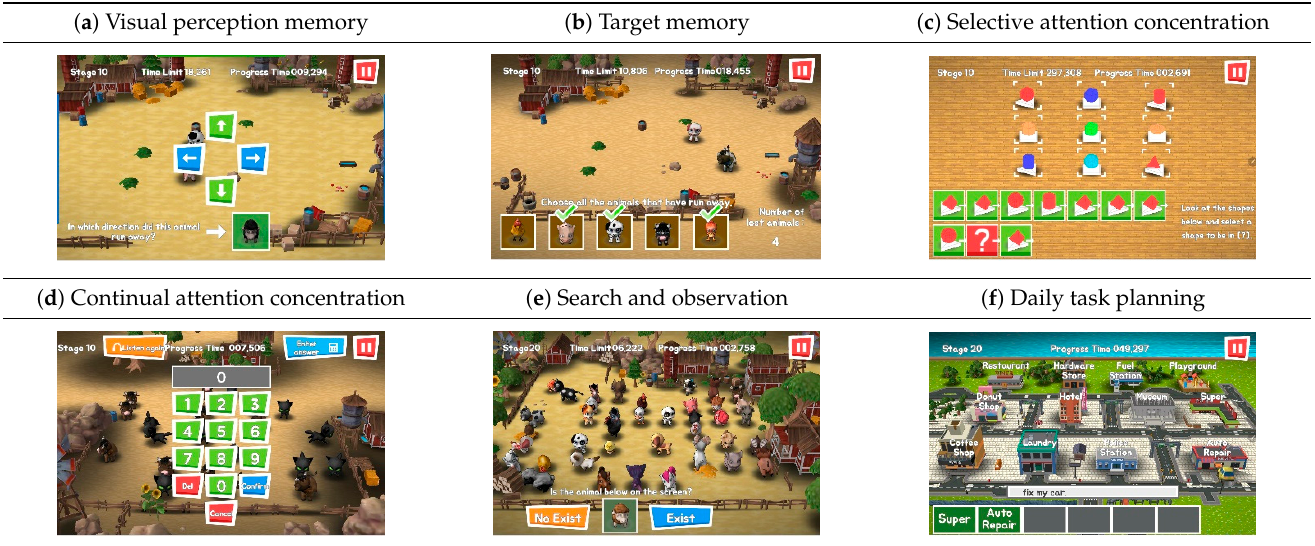
Table 2. Examples of composition of the Neuro-World cognitive training program.